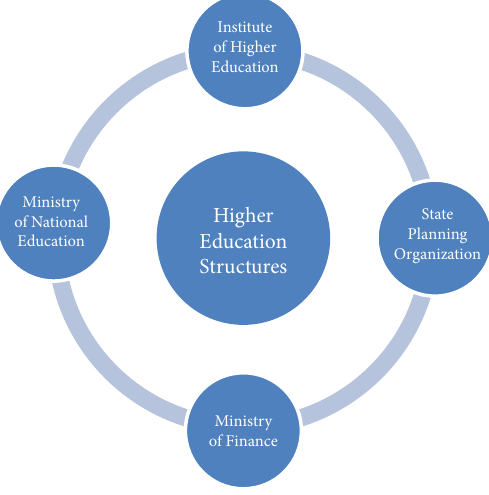
Fig. 1. Higher education structures in